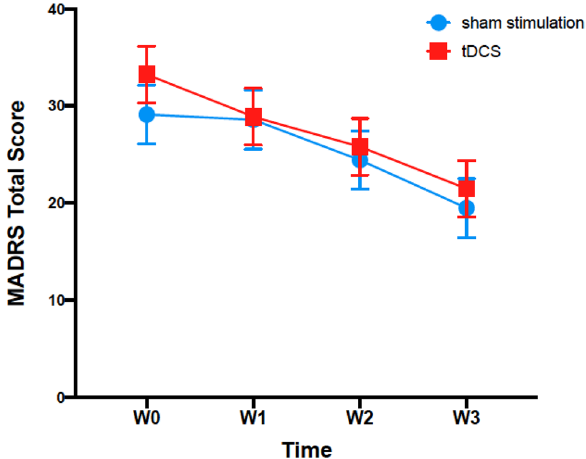
Figure 1. MADRS total score as response variable; estimated marginal means for MADRS scores for tDCS and sham stimulation groups.